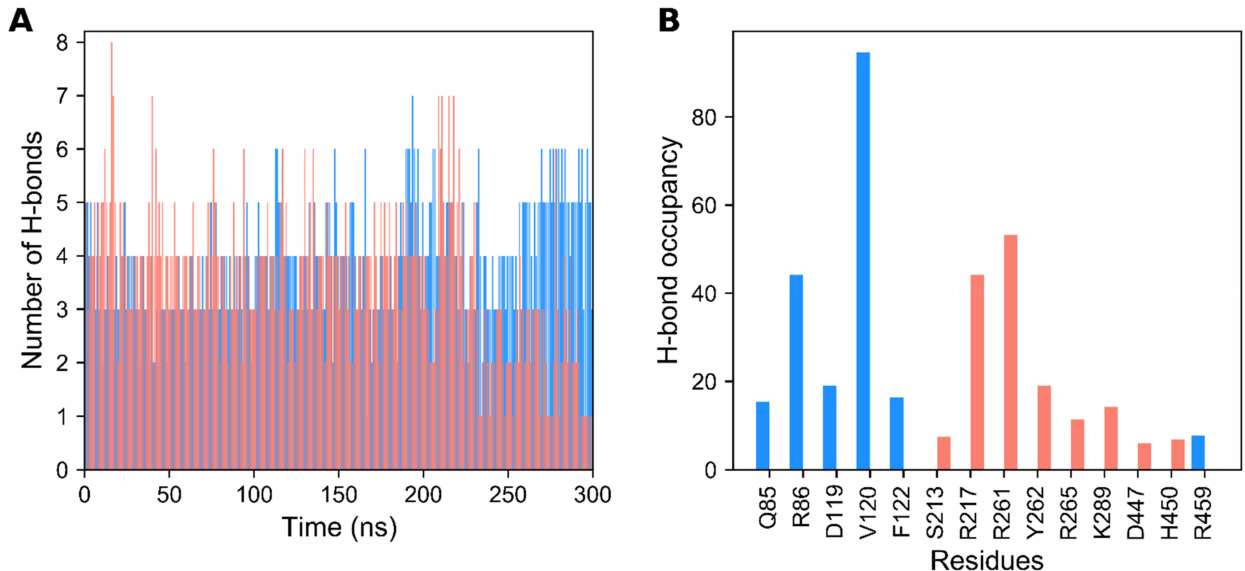
Figure 2. Hydrogen bond (H-bond) formation of agonist- and antagonist-bound GDH states during MD simulation. ( A ) Number of H-bonds formed between protein–ligand complexes during 300 ns of production time. ( B ) H-bond occupancy of each interacting residue in their relevant complexes throughout the simulation. The data for the agonist- and antagonist- bound forms of GDH are shown in dodger blue and salmon,